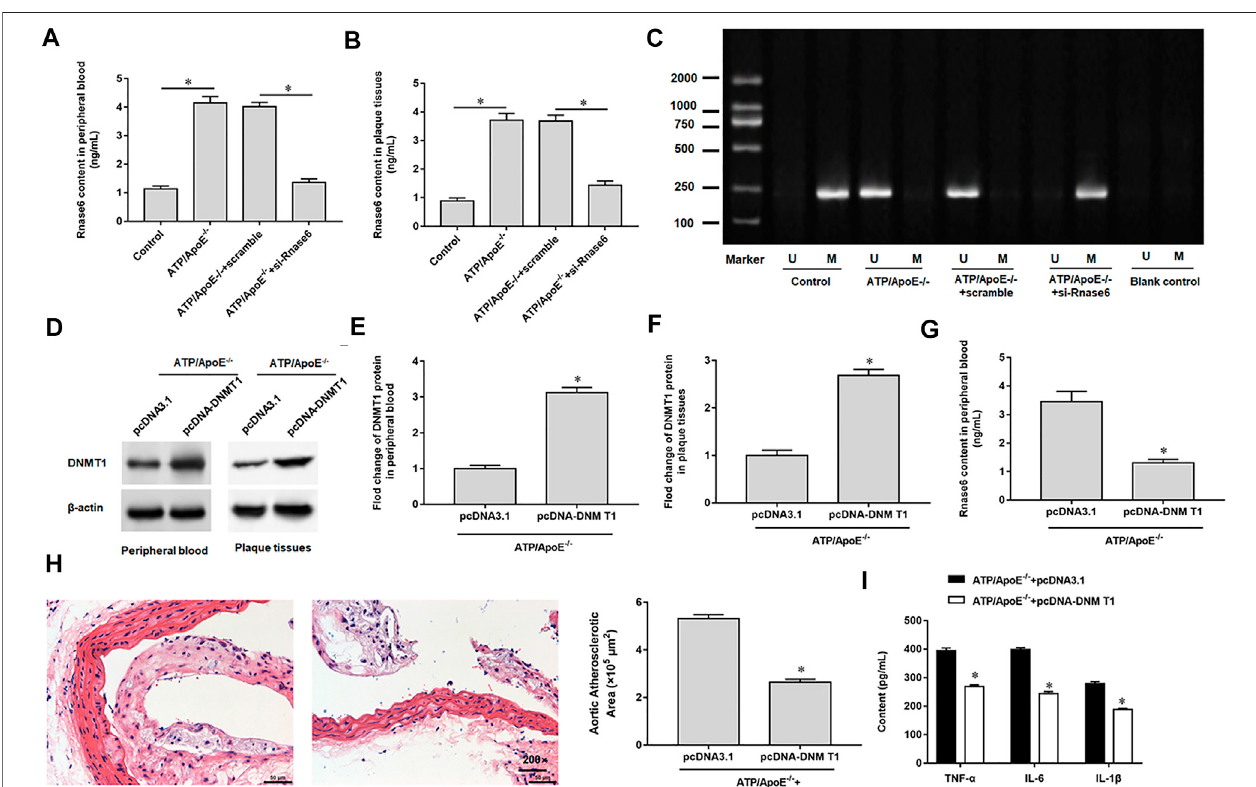
FIGURE 6 | Hypomethylation of Rnase6 promoter aggravated atherosclerosis in mice. Sixteen ApoE − / − mice were divided into control group (ApoE − / − mice were given a basal diet), model group (ApoE − / − mice were given a high-fat diet), scramble group (scramble was injected into the tail vein of high fat diet fed ApoE − / − mice, 0.5 mg/kg, twice a week) and si-Rnase6 group (si-Rnase6 was injected into the tail vein of high fat diet fed ApoE − / − mice, 0.5 mg/kg, twice a week), with four mice in each group. (A,B) . Peripheral blood and plaque tissues was collected from atherosclerosis mice, and the secretion level of Rnase6 was detected by ELISA. (C) . MSPwasusedtodetectthemethylationstatusofRnase6inperipheralbloodofatherosclerosismice.EightApoE − / − miceweredividedintopcDNA3.1group(pcDNA3.1 was injected into the tail vein of high fat diet fed ApoE − / − mice, 200 μ g/ml) and pcDNA-DNMT1 group (pcDNA-DNMT1 was injected into the tail vein of high fat diet fed ApoE − / − mice, 200 μ g/ml), with four mice in each group. (D – F) . The protein expression of DNMT1 in peripheral blood and plaque tissues was detected by Western blotting. (G) .TheexpressionofRnase6inperipheralbloodwasdetectedELISA. (H) .HEstainingwasperformedontheplaquetissueoftheaorticrootofmicetoobserve the area of plaque formation. (I) . Relative secretion levels of TNF- α , IL-6 and IL-1 β were analyzed by ELISA kits. N (cid:2) 6, * p <